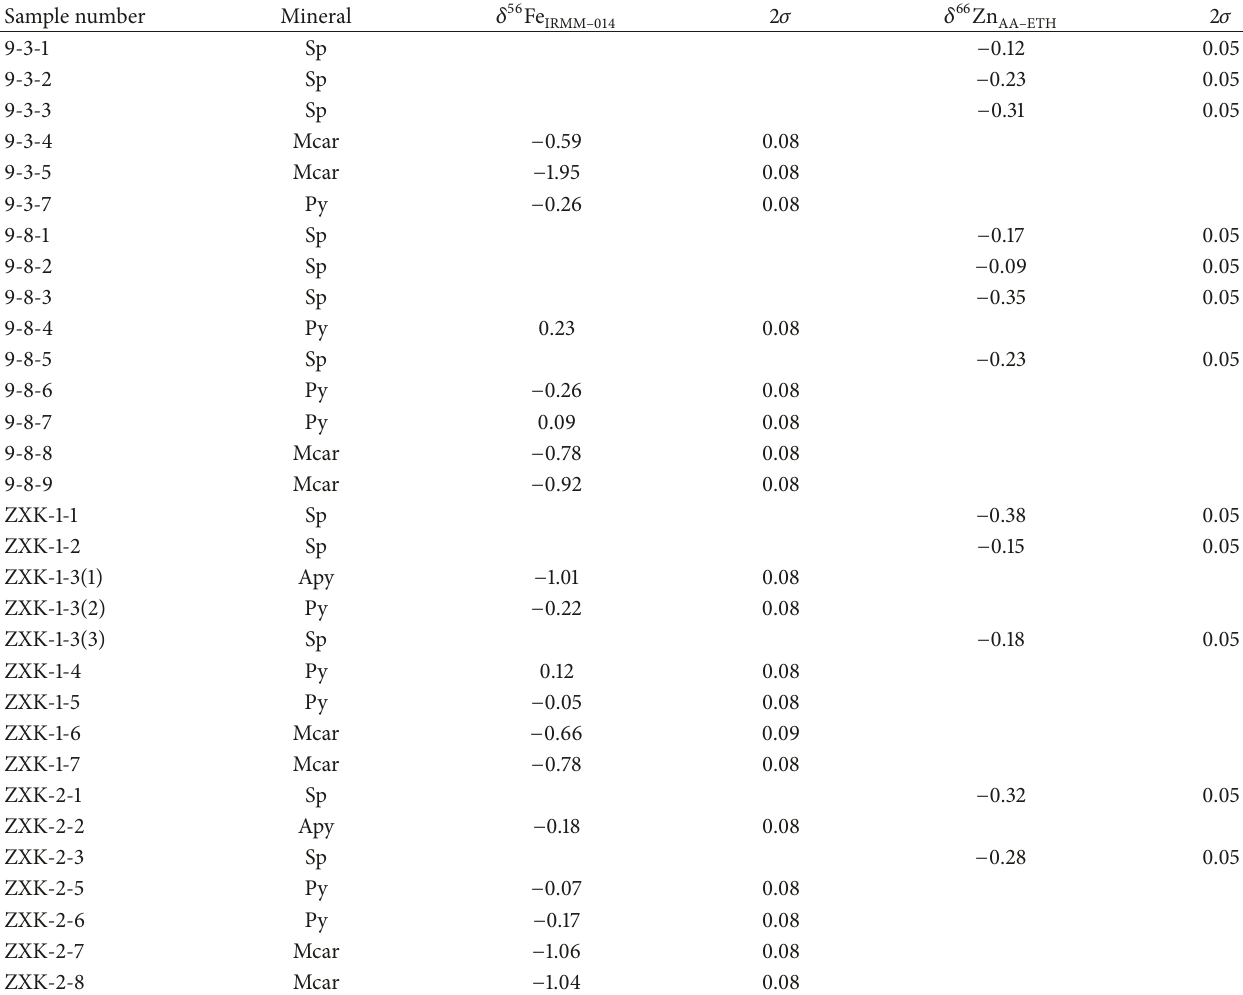
Table 3: Fe-Zn isotopic data for annular polished section samples from the Zhaxikang